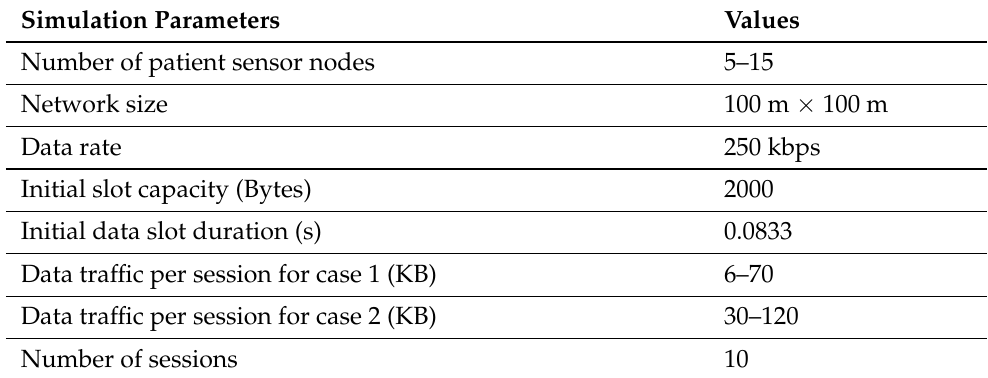
Table 3. Simulation Parameters.